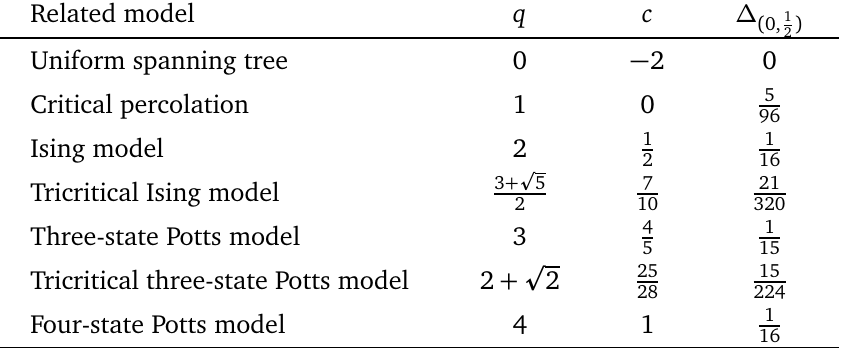
) in a number of special cases. The ambiguities in the relation 0, 1 2